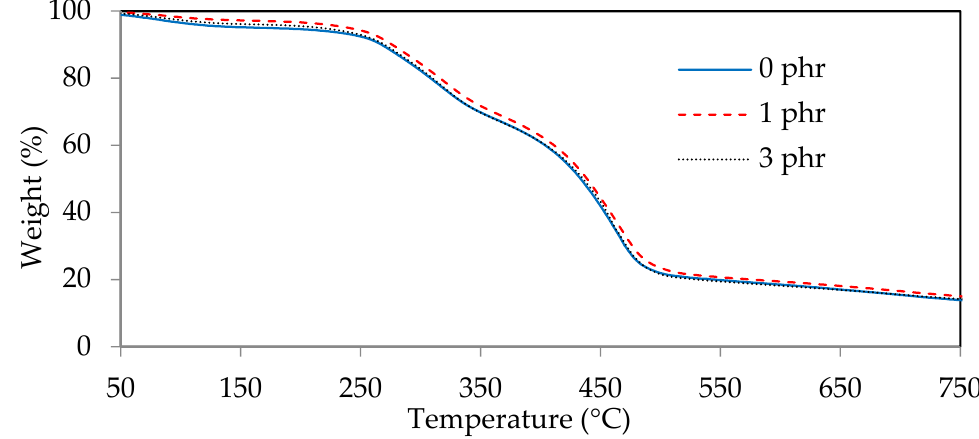
The thermogravimetric diagrams (TGA) and derivative thermogravimetric diagrams